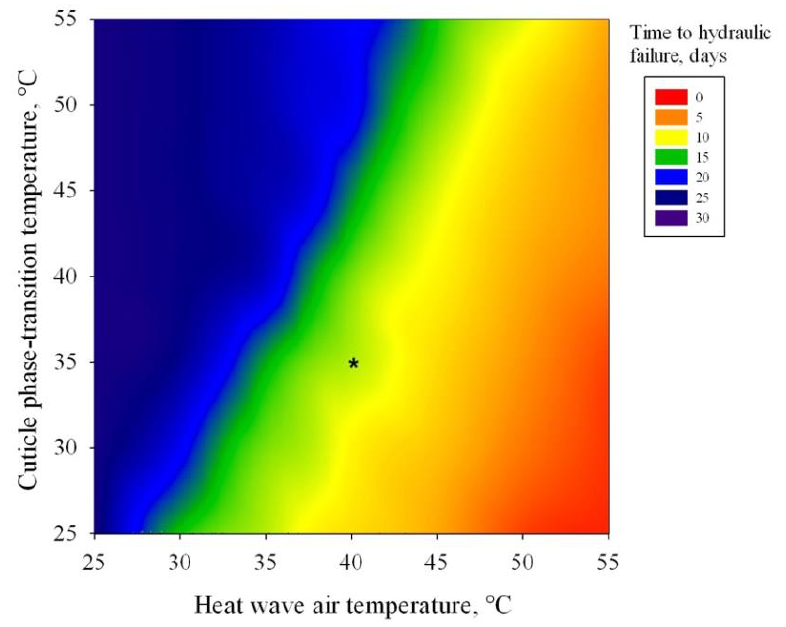
Figure 7. Effects of the phase transition temperature and the maximum heatwave temperature on the time to hydraulic failure. The asterisk corresponds to the control plant (Tp = 35°C) exposed to a +15°C